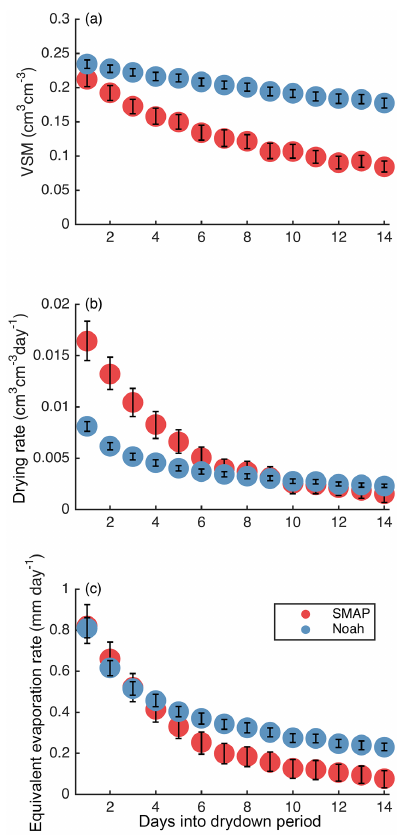
Figure 6. Soil moisture (a) , drying rate (b) , and equivalent evapora- tion rate (c) as a function of days into the drydown period. Markers show median values. Error bars show standard